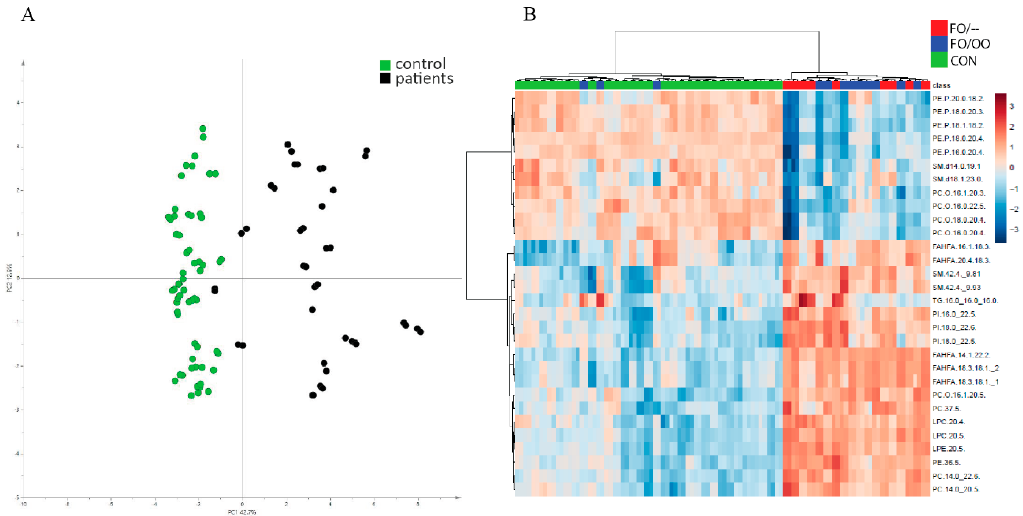
Figure 1. Plasma lipidome. ( A ): Principal Component Analysis (PCA) score plot based on all confirmed plasma lipids ( n = 102) showing two separated clusters of control samples as green points and patient samples as black points. ( B ): Hierarchical clustering analysis of individual control and patient plasma samples according to all lipids with VIP score ˃ 1.0 ( n = 30). The most distant clusters are a group consisting of controls and three FO/OO subjects on one side and all FO/– patients plus ten FO/OO patients on the other side. Within the later cluster, no special clustering according to the presence/absence of OO was seen. PCA principal component analysis; OO, olive oil; FO, fish oil.